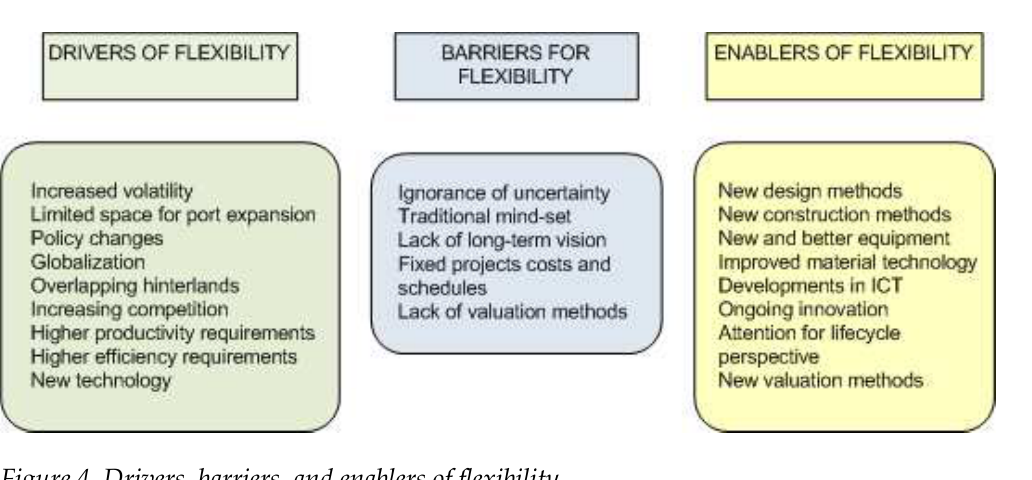
Figure 4. Drivers, barriers, and enablers of